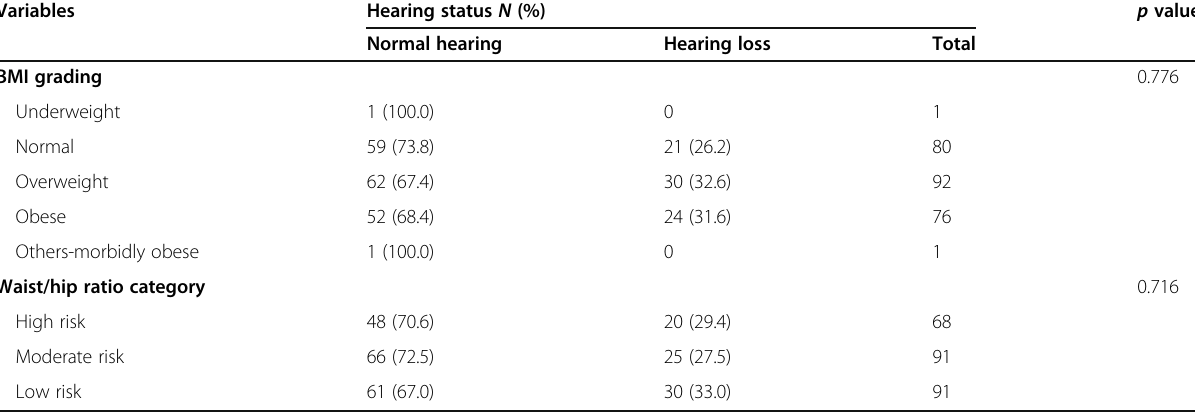
Table 4 Relationship between body mass index and wait/hip ratio with hearing status Variables Hearing status N (%) p value Normal hearing Hearing loss Total BMI grading 0.776 Underweight Normal Overweight Obese Others-morbidly obese 1 (100.0) Waist/hip ratio category High